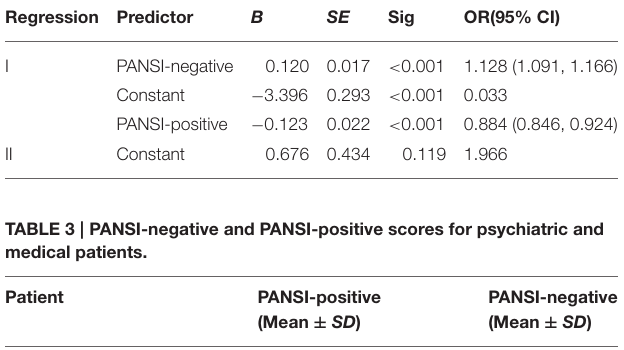
TABLE 2 | Results from logistic regressions. Regression Predictor